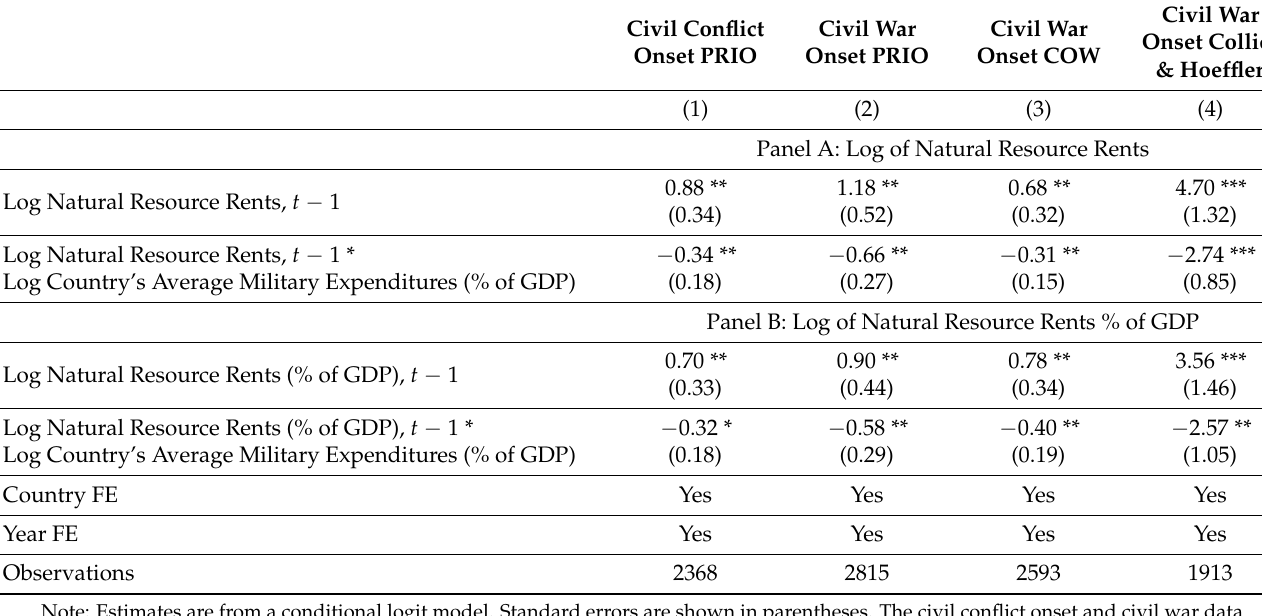
Table 9. Robustness: Alternative Civil Conflict and Civil War Onset Datasets.